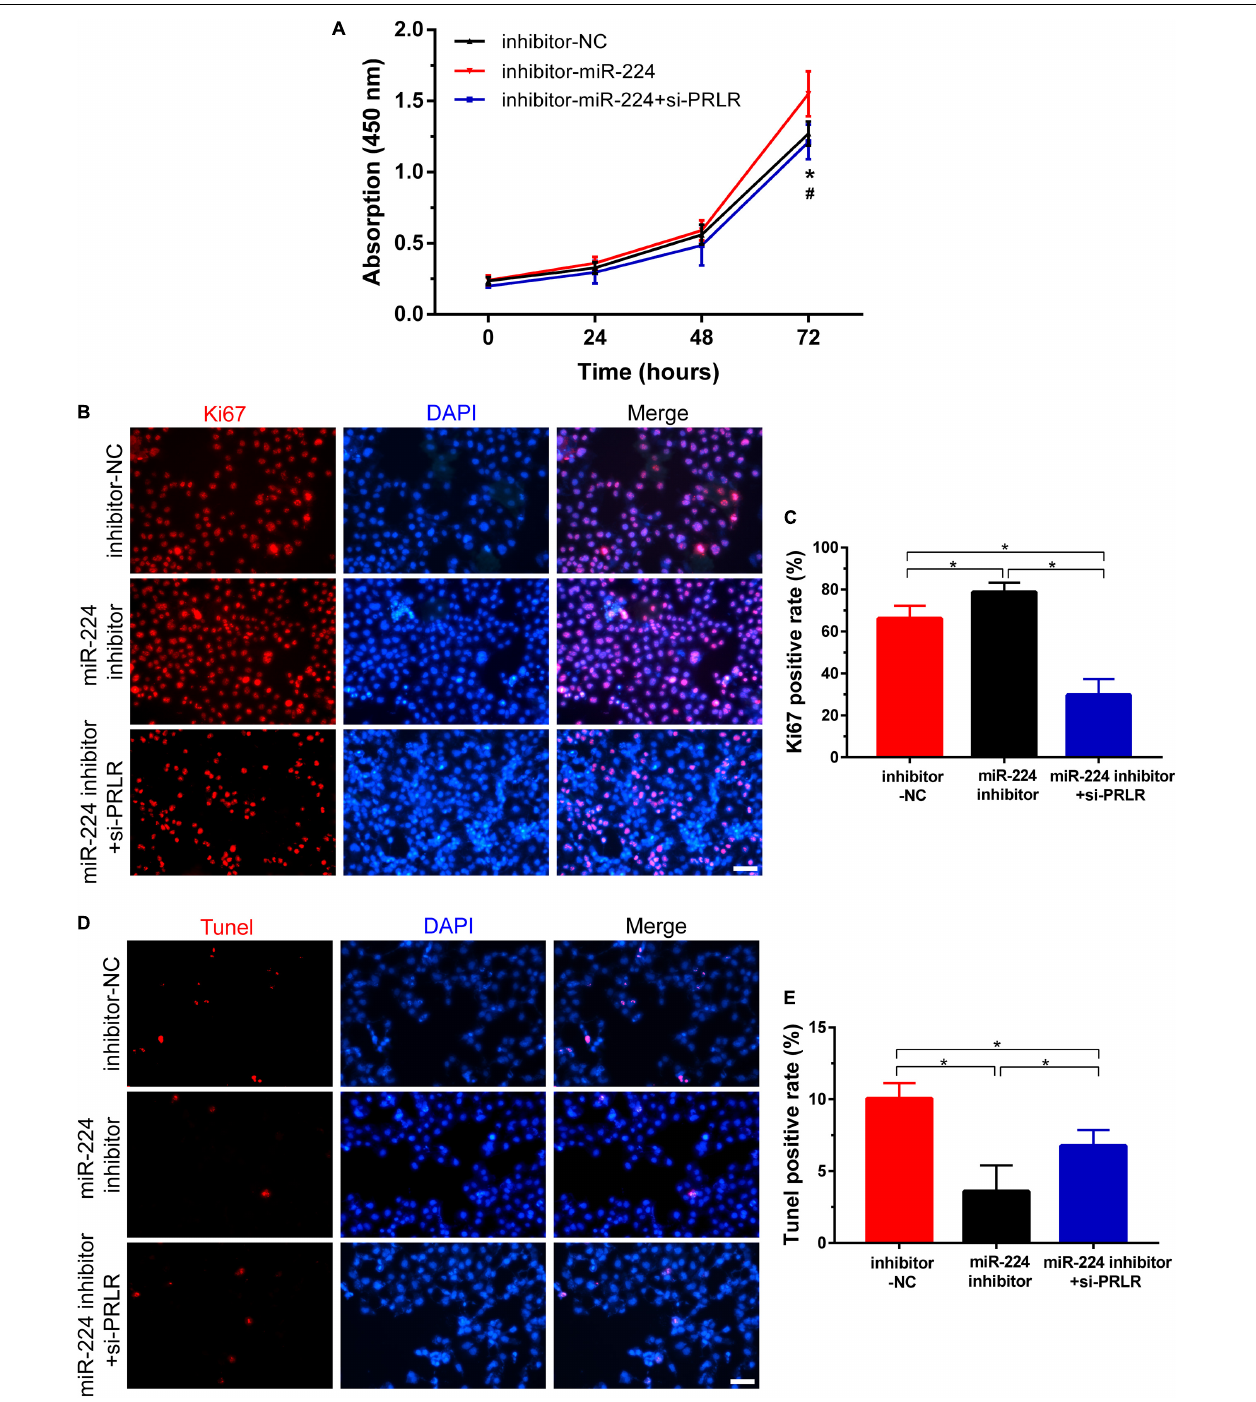
FIGURE 4 | Circ-CYP24A1 regulated cell proliferation and apoptosis via the miR-224-PRLR axis. (A) Cell viability was detected in Ishikawa cells transfected with miR-224 inhibitor or co-transfected with miR-224 inhibitor and PRLR siRNA using CCK8 assay. (B) Immunofluorescence staining for Ki67 in Ishikawa cells. (C) Quantitative group data for Ki67 positive cells. (D) Apoptosis of Ishikawa cells was tested using the TUNEL assay. (E) Quantitative group data for TUNEL positive cells. inhibitor-NC, negative control to miR-224 inhibitor; #, comparison between miR-224 inhibitor and miR-224 inhibitor + si-PRLR (* p < 0.05, # p < 0.05). Scale bar: 100 µ